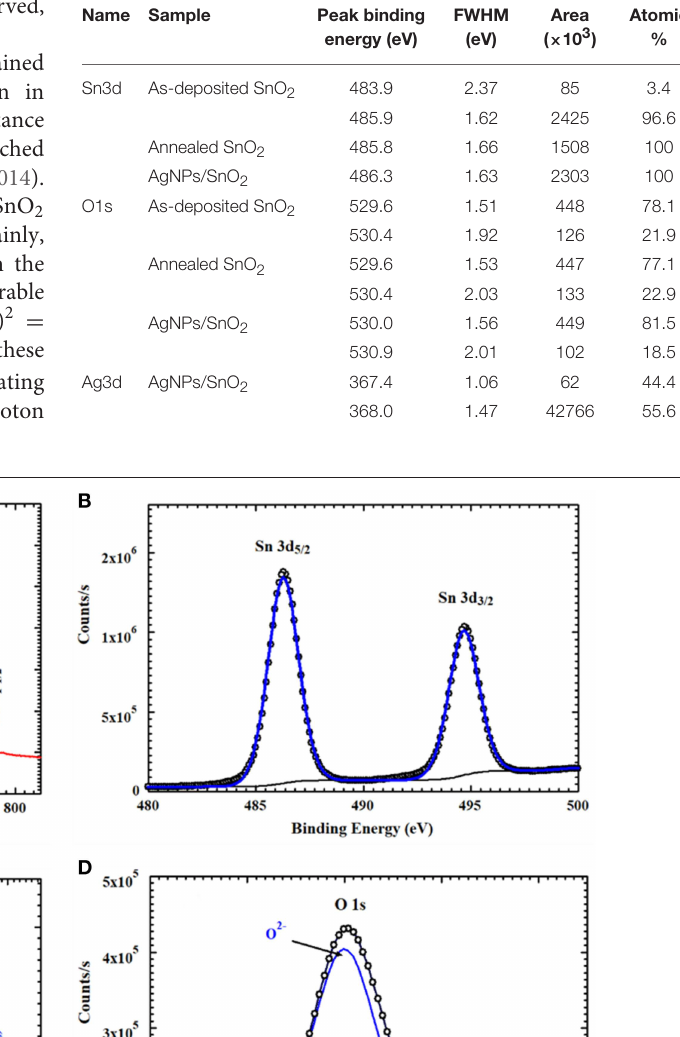
2 , and AgNPs/SnO 2 .